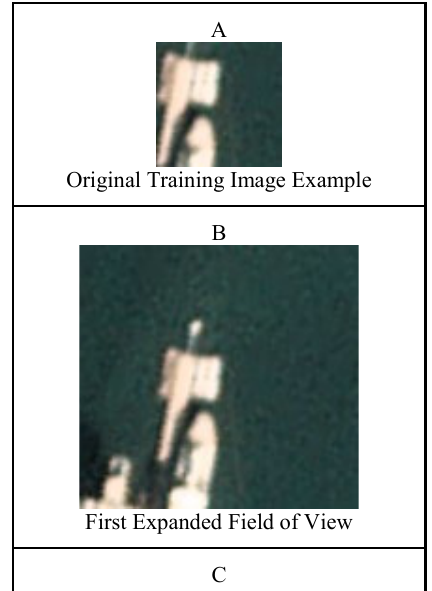
Figure 10. Sample image of larger